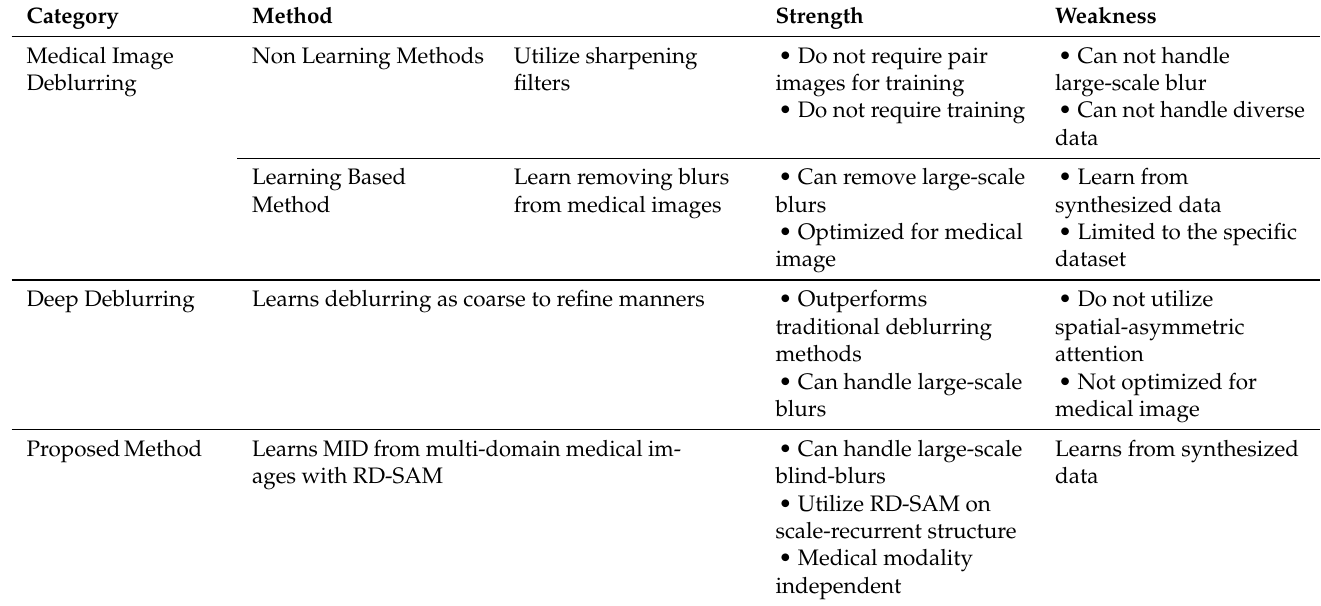
Table 1. Comparison between existing methods and the proposed